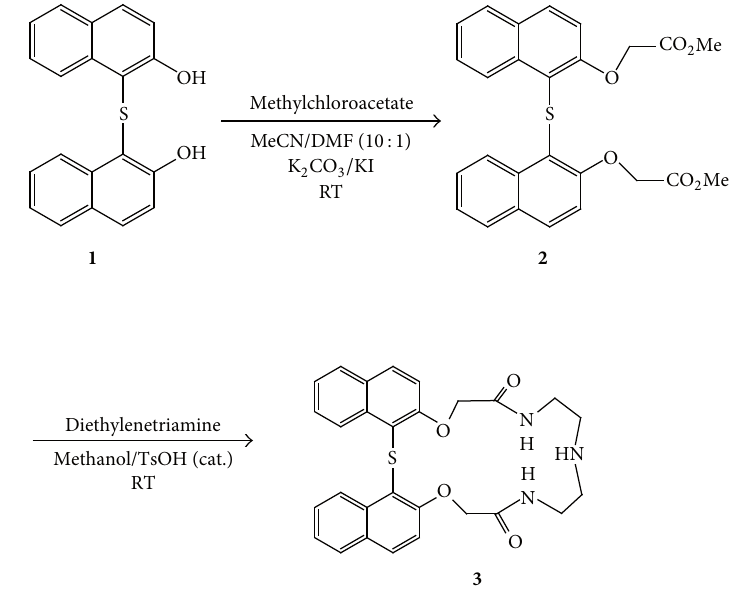
S 1: Synthesis of initial macrocycle ( 3